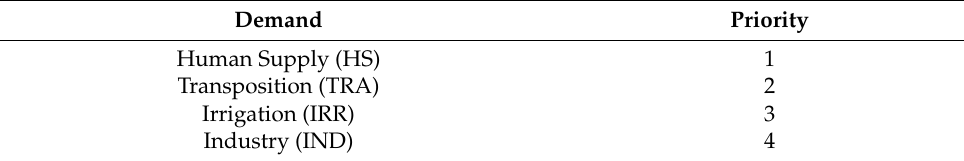
Table 4. Priority ranking for reservoir system simulation. Demand Priority Human Supply (HS) 1 Transposition (TRA) 2 Irrigation (IRR) 3 Industry (IND)